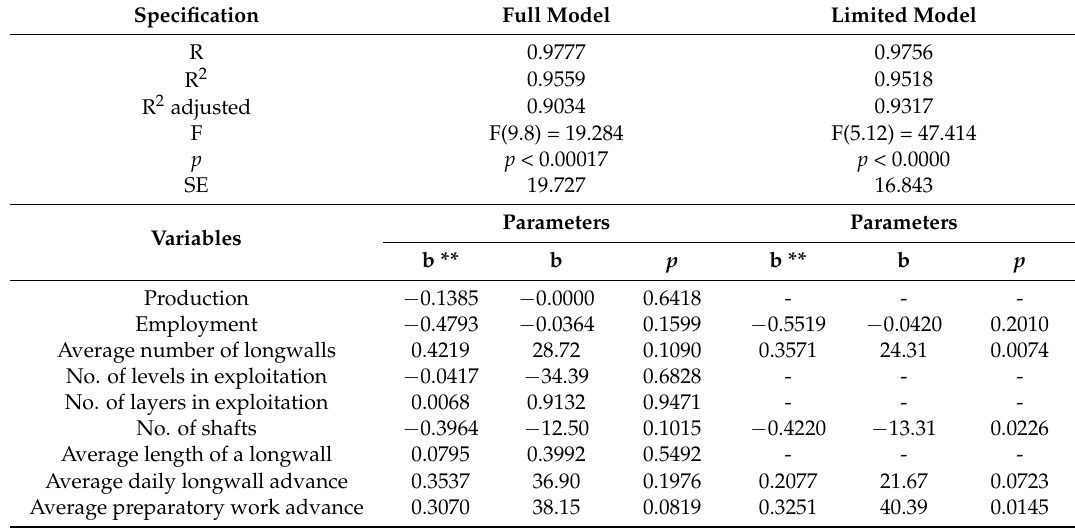
Table 5. Regression models for CM4.